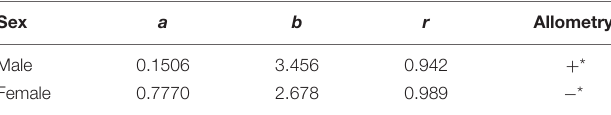
TABLE 1 | Regression parameters of the length-weight relationship for P. polyphagus .